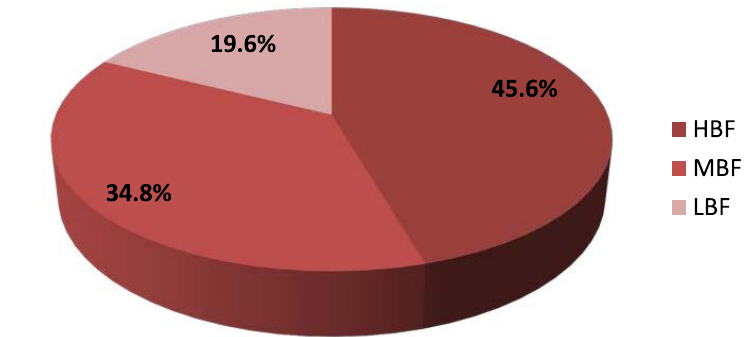
Fig. 4. Percentage of biofilm forming Staphylococcus aureus isolates; OD values less than 0.150 were recorded as low biofilm forming isolates, those with OD values between 0.150 to 0.250 were considered as moderate biofilm formers and those with OD values above 0.250, were considered as high biofilm forming